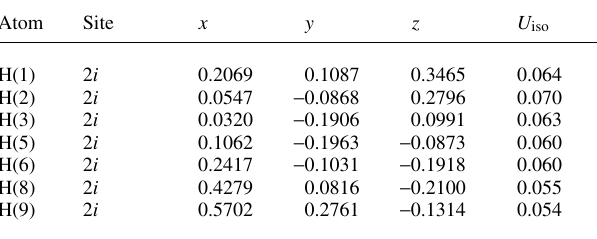
Table 2. Atomic coordinates and displacement parameters (in Å 2 )